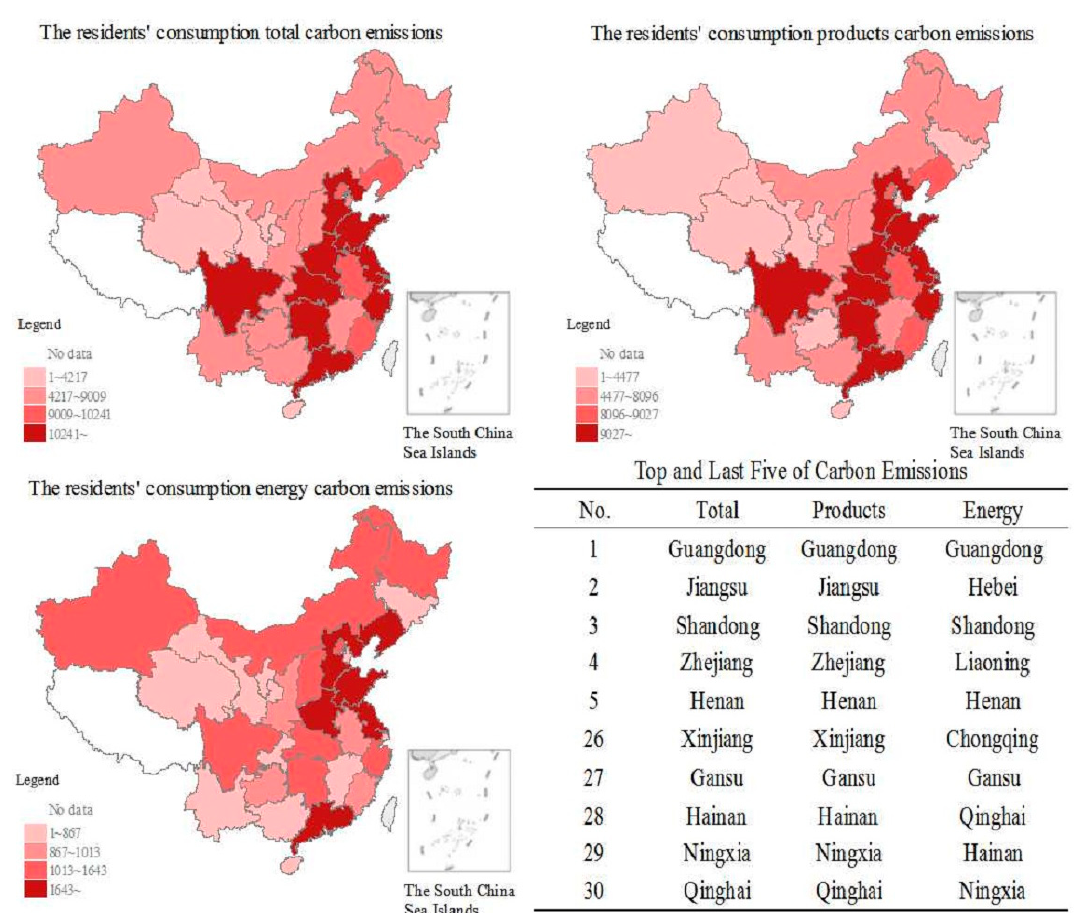
Figure 3. The spatial distribution of the total carbon emissions of China’s household consumption in 2015.